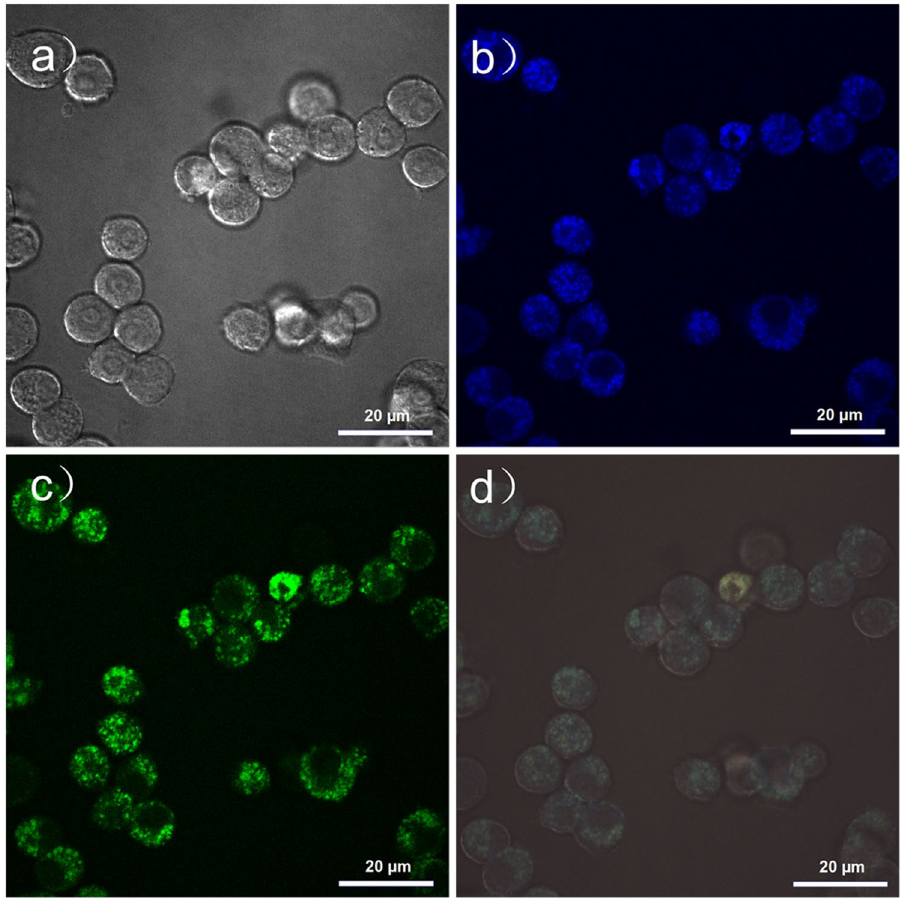
Figure 7. Representative upconversion photoluminescence images of RAW 264.7 cells incubated with N-dots (0.5 mg/mL) for 6 h at 37 °C. ( a ) Bright field image, ( b , c ) photoluminescence images obtained at ( b ) 425–475 nm and ( c ) 500–550 nm under 770 nm excitation, ( d ) superimposed image of ( b ) and ( c ). Scale bar: 20 µ